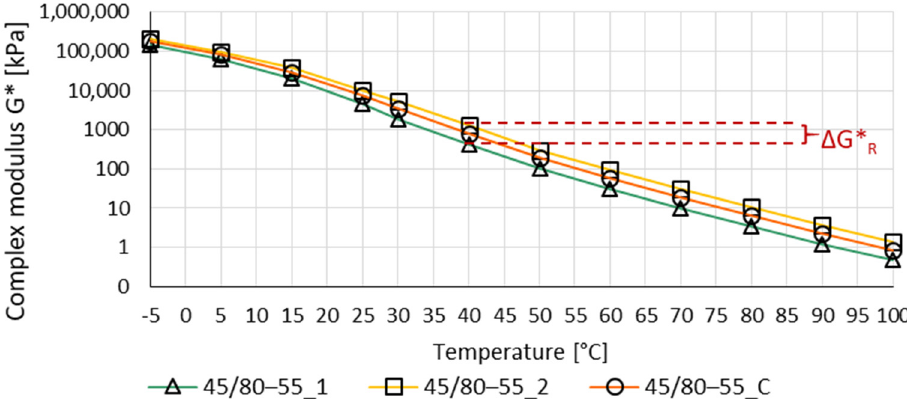
Figure 3. Complex modulus G* for PMB 45/80–55 virgin binder; an example of determining the ∆ G* R index. (45/80–55_1—outer layer of bitumen film with virgin binder 45/80–55; 45/80–55_2—inter layer of bitumen film with virgin binder 45/80–55; 45/80–55_C—whole bitumen film with virgin binder 45/80–55).